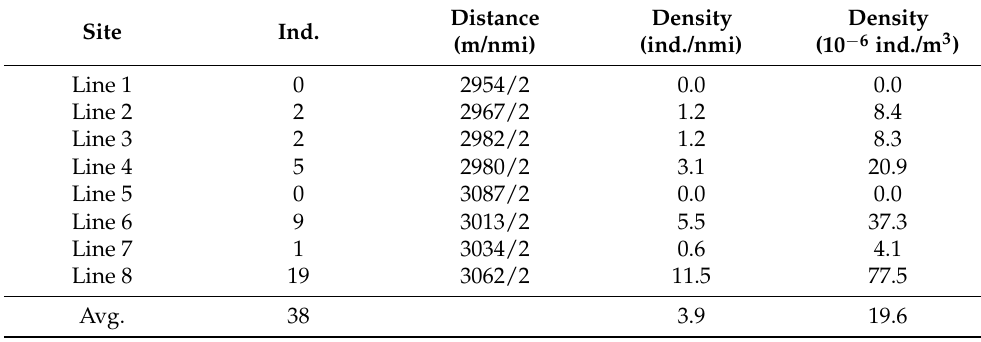
Table 13. Distribution density of jellyfish using the sighting method in the Gijang coastal waters sea (7/22).